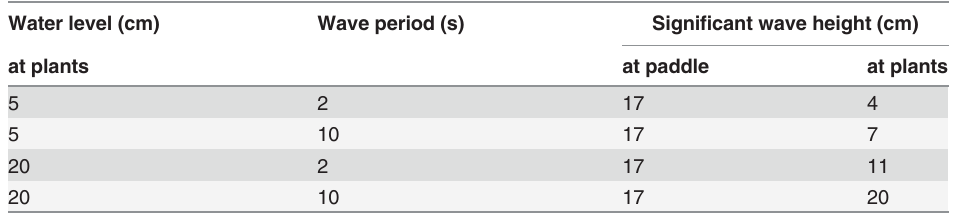
Table 1. Details of the four tested wave